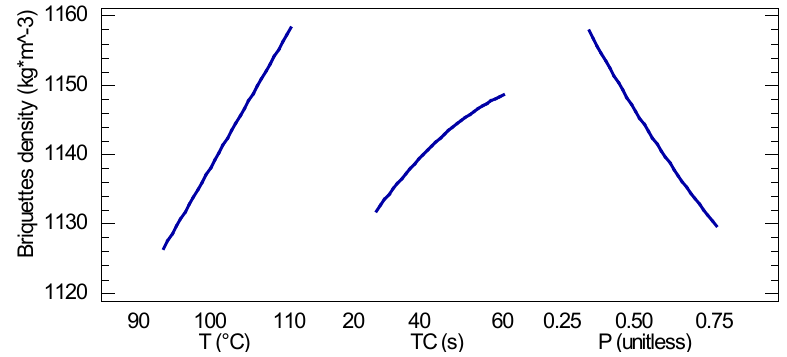
Figure 2. Main e ff ects for briquettes density considering the experimental factors of process temperature, Figure 2. Main effects for briquettes density considering the experimental factors of process compaction time and proportion of rice husk in the temperature, compaction time and proportion of rice husk in the mixture.